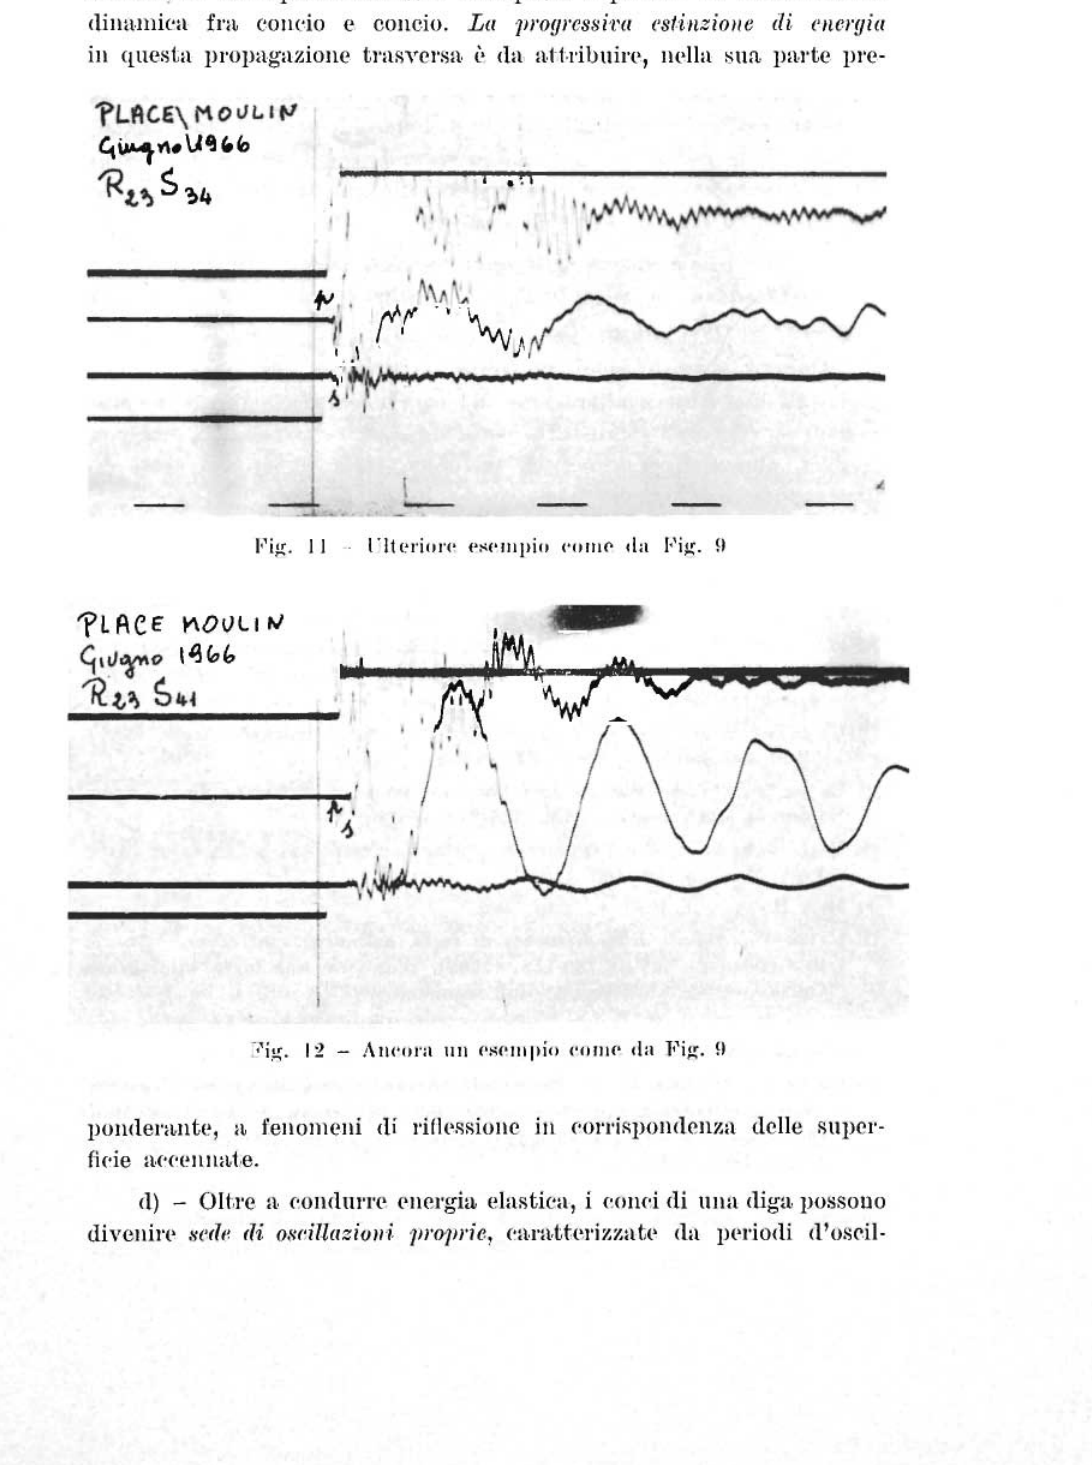
(1 ig. 12 - Ancora un esempio come da Fig. 9 ponderante, a fenomeni di riflessione in corrispondenza delle super- fìcie